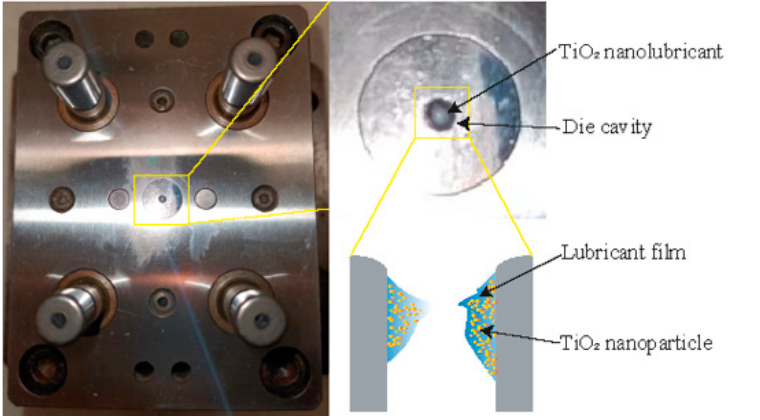
Figure 3. Schematic diagrams of the deep drawing configuration under TiO 2 NP lubrication condition. Table 3. Various compositions of lubricants.